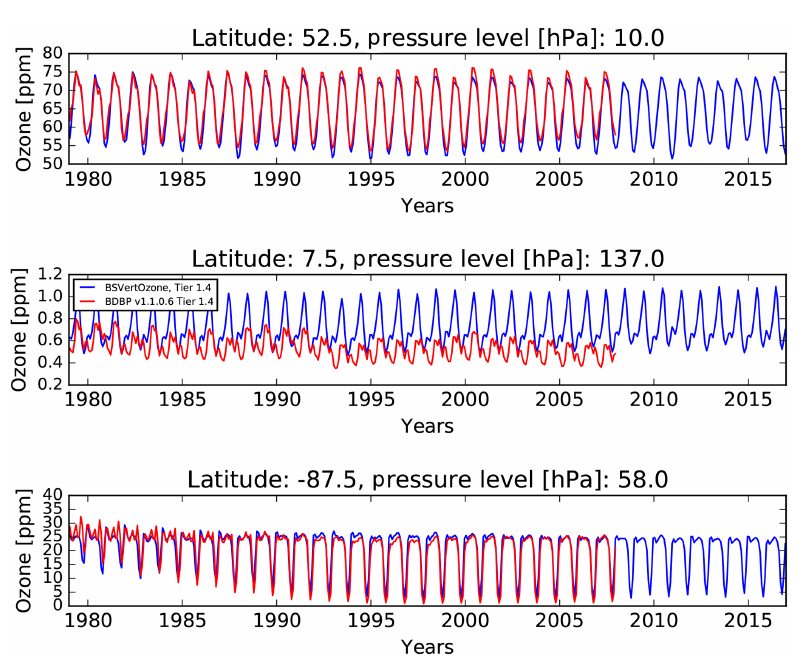
Figure 8. Ozone concentrations as extracted from BDBP v1.1.0.6 Tier 1.4 (red line) and BSVertOzone Tier 1.4 (blue line) for three different pressure levels and three different latitude